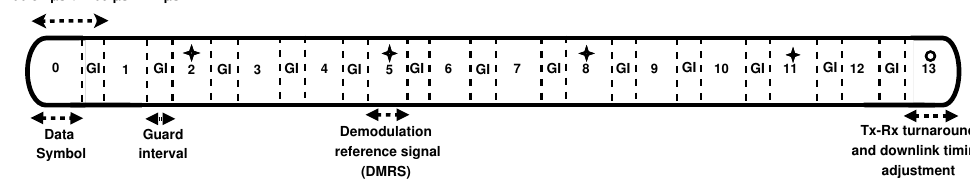
Figure 2. LTE-V2X frame structure with a 10 MHz bandwidth